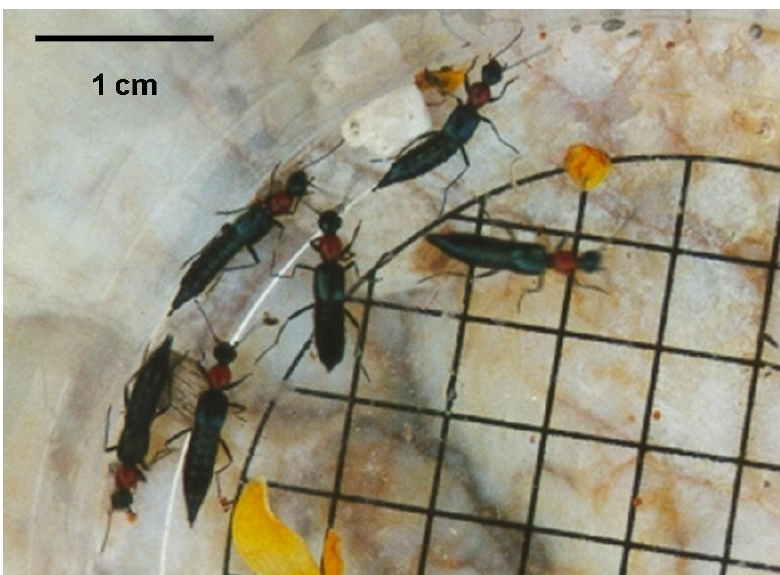
Figure 8. Paederus littoralis , a frequent species of Pars-Abad district, north-western Iran.